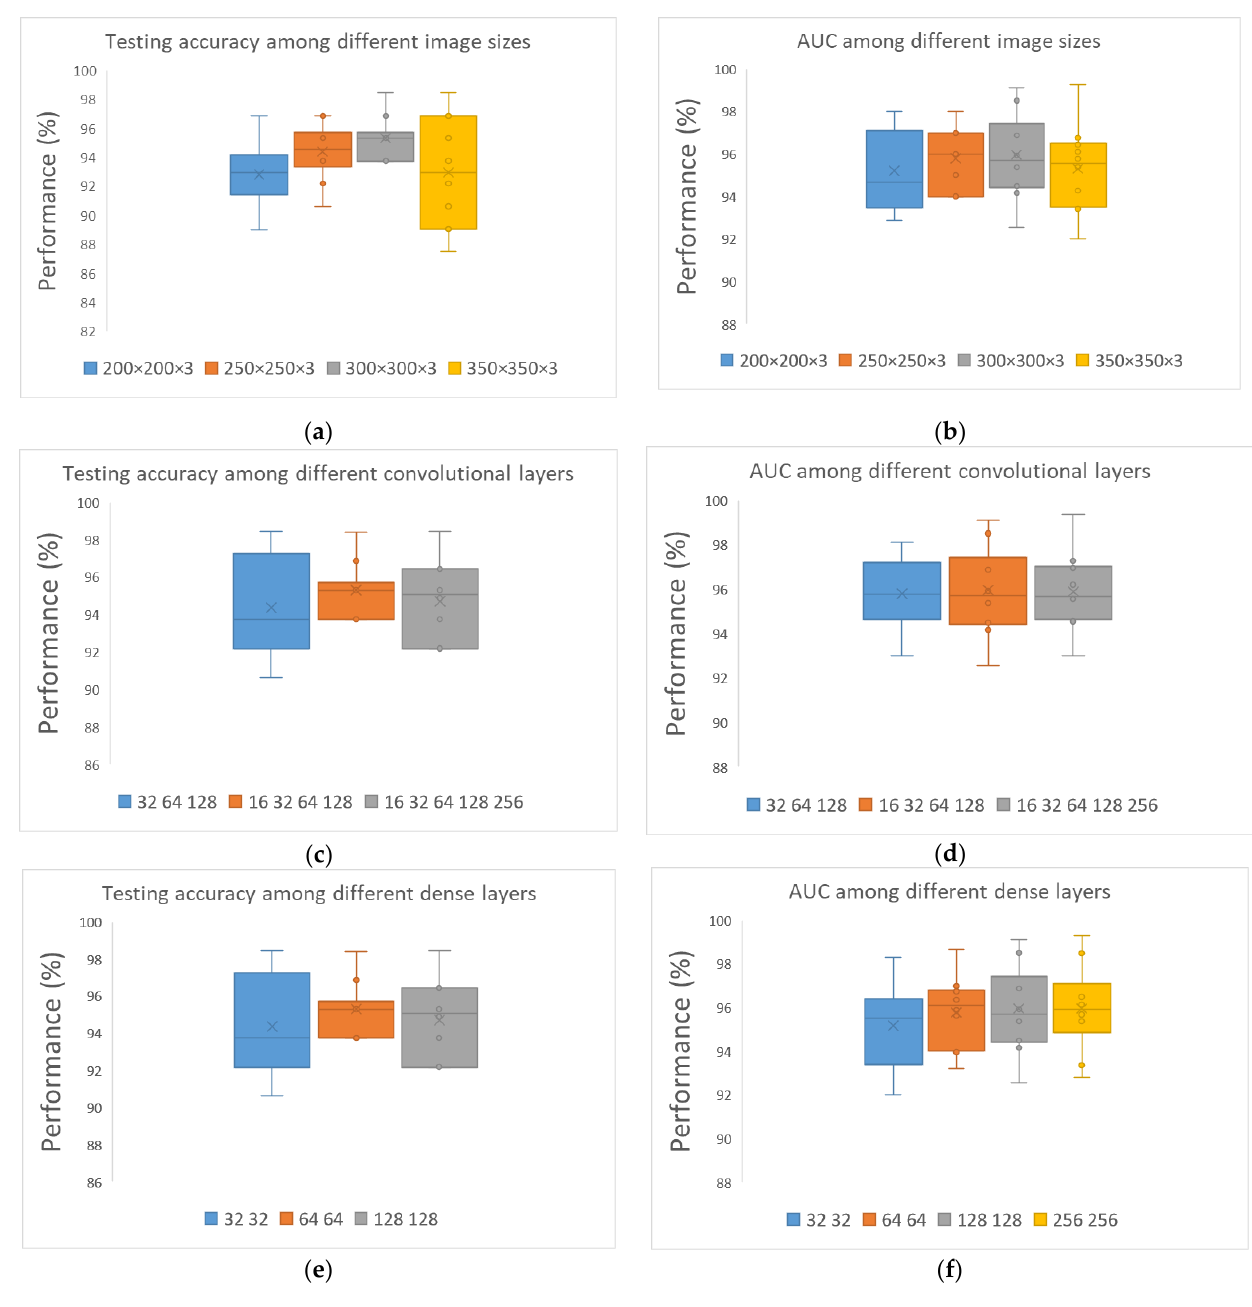
Figure 3. Convolutional neural network architecture for CAD classification problem comparing various values for all parameters: ( a ) Testing accuracy for different image sizes; ( b ) AUC for different image sizes; ( c ) testing accuracy for different convolutional layers; ( d ) AUC for different convolutional layers; ( e ) testing accuracy for different dense layers; and ( f ) AUC for different dense layers.